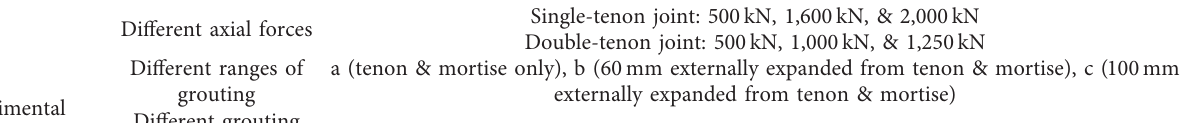
Figure 2: Construction structure of grouted mortise-tenon joint (unit: mm). (a) Double-tenon joint, (b) long single-tenon joint, (c) short single-tenon Table 1: Experimental cases.